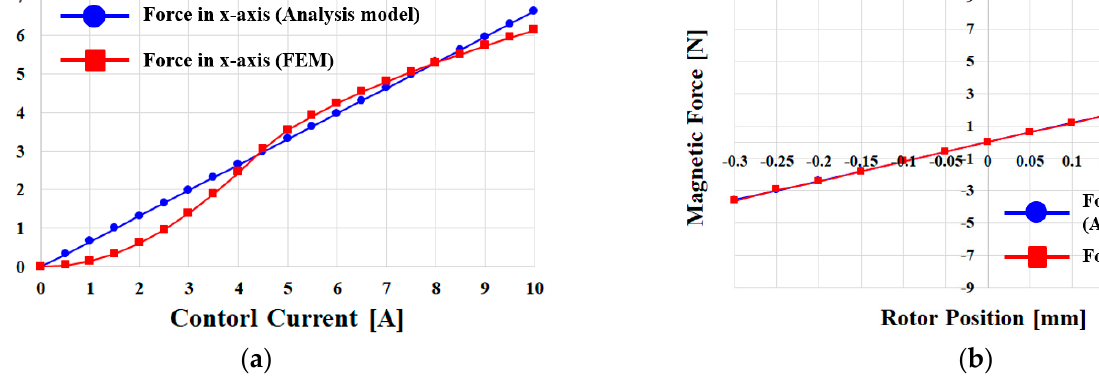
Figure 3. Current stiffness and displacement stiffness for the FEM and magnetic equivalent circuit in the existing model: ( a ) the force on the x -axis according to the control current and ( b ) the force on the x -axis according to the rotor position.